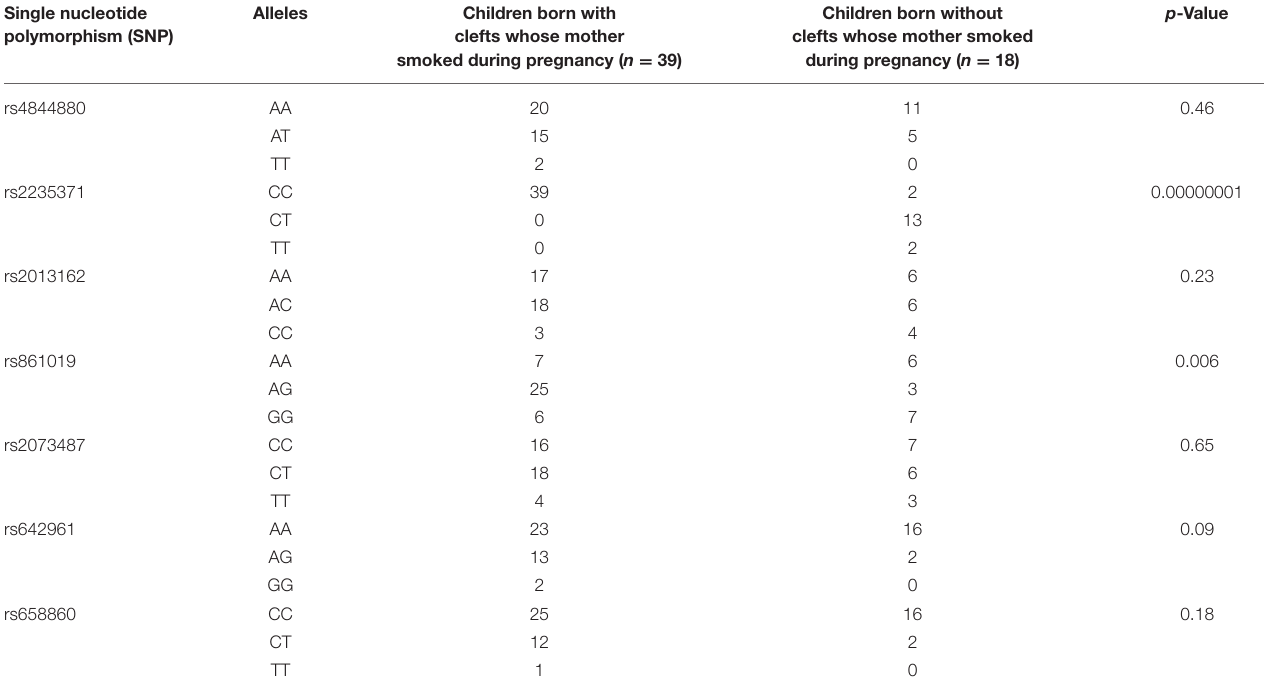
TABLE 1 | Genotyping frequency and summary association results. Single nucleotide polymorphism (SNP)